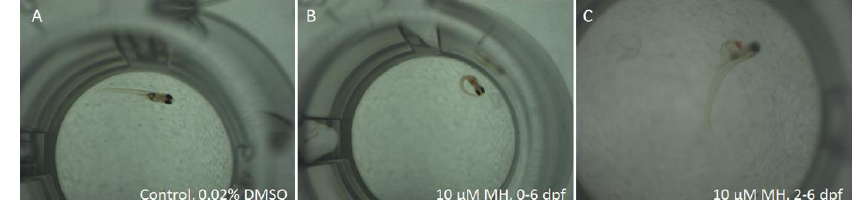
Figure A1. Examples of images representing the medaka phenotype following MH treatment. Medaka embryos were treated with 10 µ M MH or an untreated control batch (0.02% DMSO) for 0–6 dpf or 2–6 dpf following the same protocol as described in the method. ( A ) Control. No phenotypic abnormality was detected with the control for the two groups. This first image displays an example of a typical control obtained immediately for both treatment plans. ( B ) This is an example of a typical medaka treated with 10 µ M MH for 0–6 dpf. Curved tail phenotypes were observed in many. ( C ) Edema phenotypes were observed in medaka treated with 10 µ M MH for 2–6 dpf. Bent tail phenotypes were observed in few.